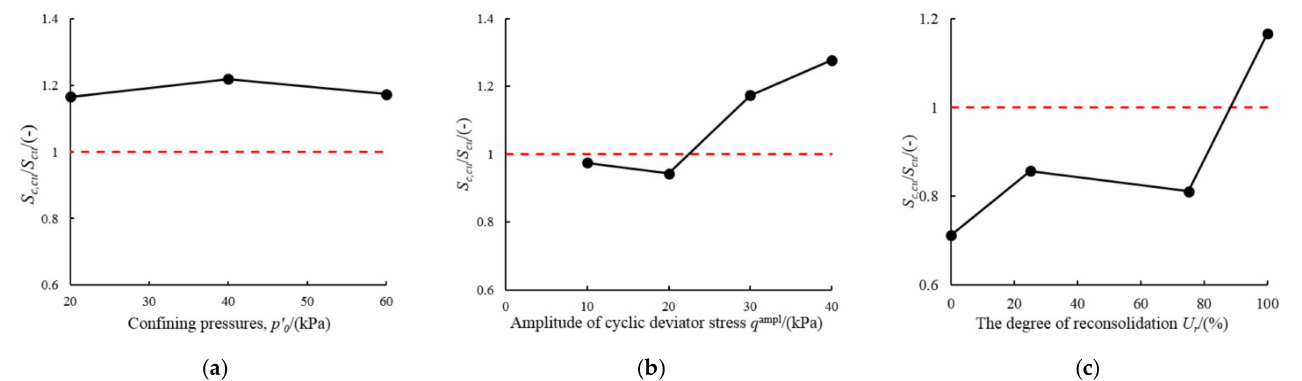
Figure 16. Comparison between undrained shear strength with and without cyclic loading considering different influence factors: ( a ) different confining pressures; ( b ) different cyclic stress ratios; ( c ) different degrees of